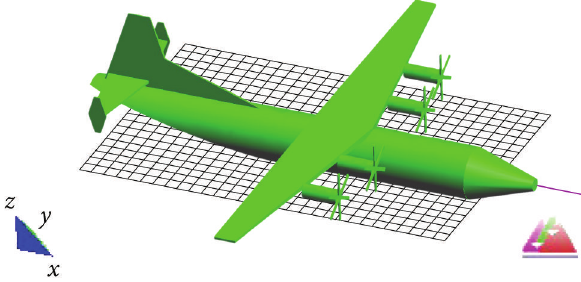
Figure 7: Model of Y-8 aircraft.